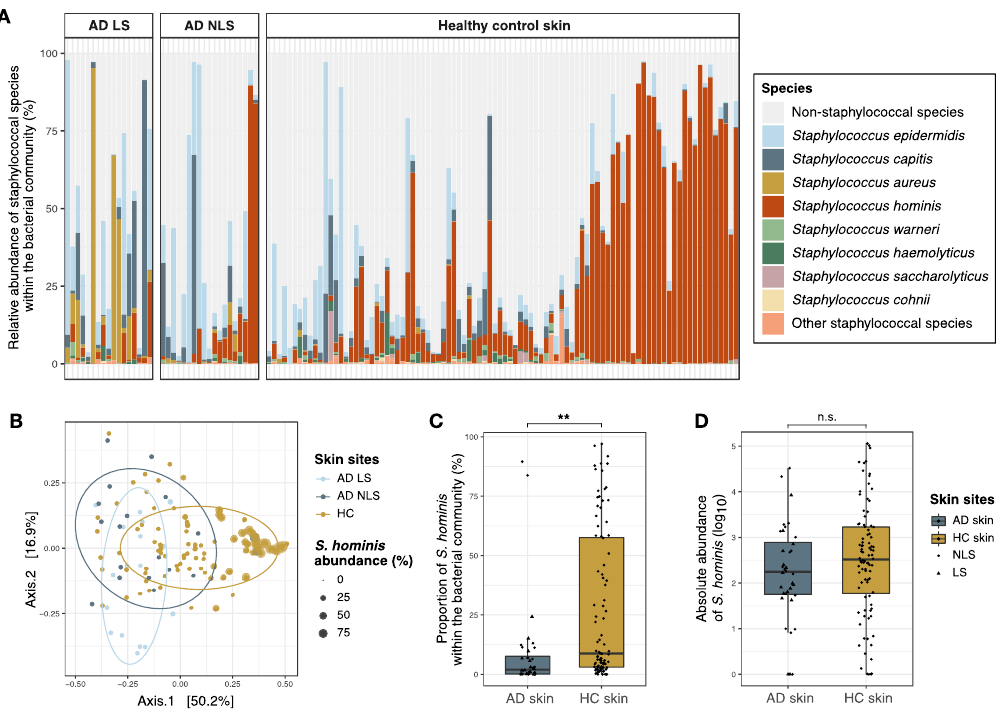
Figure 6. Staphylococcal communities on the antecubital crease of AD patients and healthy individuals . ( A ) Bar plot showing the relative abundances of the eight most abundant staphylococcal species within the bacterial community of AD lesional skin ( n = 17), AD non-lesional skin ( n = 19), and healthy control skin ( n = 92). ( B) PCoA plot showing the compositional differences in staphylococcal communities on AD skin and healthy control skin. Point sizes are scaled based on the relative abundance of S. hominis within the bacterial community. Of note, two AD non-lesional skin samples with high S. hominis abundance cluster together with healthy control skin on the right side of the plot. ( C) The relative abundance of S. hominis within the cutaneous bacterial community. ( D ) The absolute abundance of S. hominis on skin, which was calculated by combining proportional amplicon sequence data with 16S rRNA qPCR data. Thus, the absolute abundance is equivalent to the number of S. hominis 16S rRNA gene copies within 1µl DNA eluate (log10 transformed counts). Box plots represent the median and interquartile range (IQR) with whiskers extending to the minimum/maximum value, but no longer than 1.5 × IQR, and lesional and non-lesional skin samples are visualized as triangles and dots, respectively. Asterisks indicate a significant difference: ** p < 0.01, n .s.: not significant. Abbreviations: AD: atopic dermatitis; LS; lesional skin; NLS: non-lesional skin; HC skin: healthy control skin.